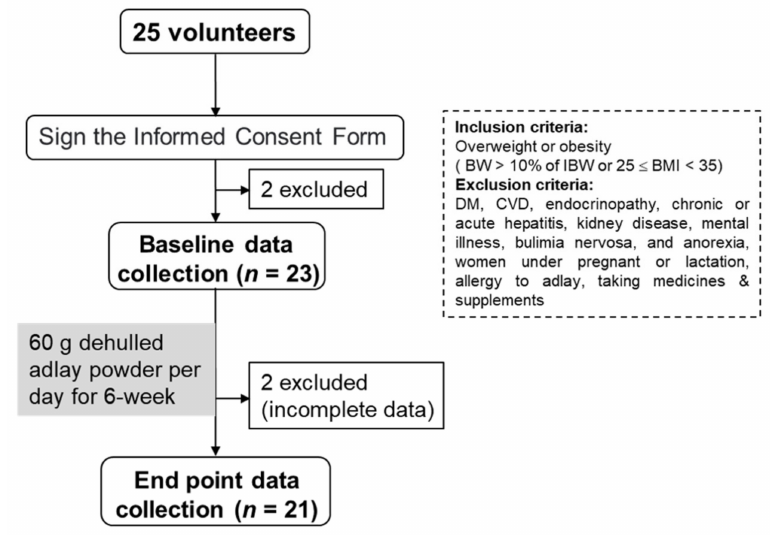
Figure 1. Flow chart of the study protocol. BW, body weight; IBW, ideal body weight; DM, diabetic mellitus; and CVD, cardiovascular